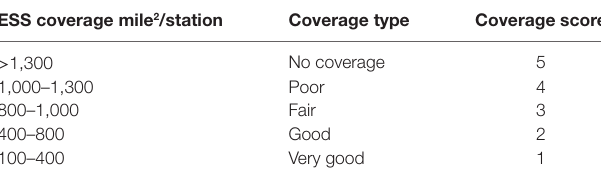
TaBle 6 | Scoring scheme for environmental sensor station (ESS) coverage.